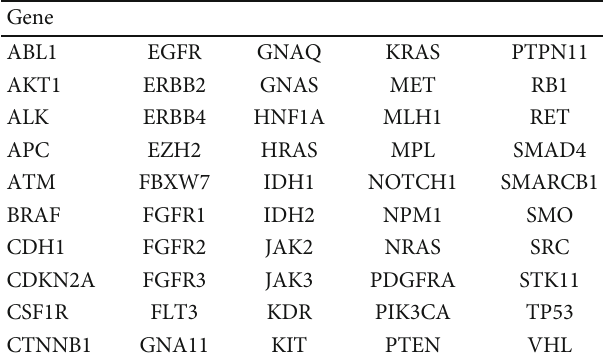
Table 1: Fifty cancer-related genes utilizing Ion AmpliSeq ™ Cancer HotSpot v2